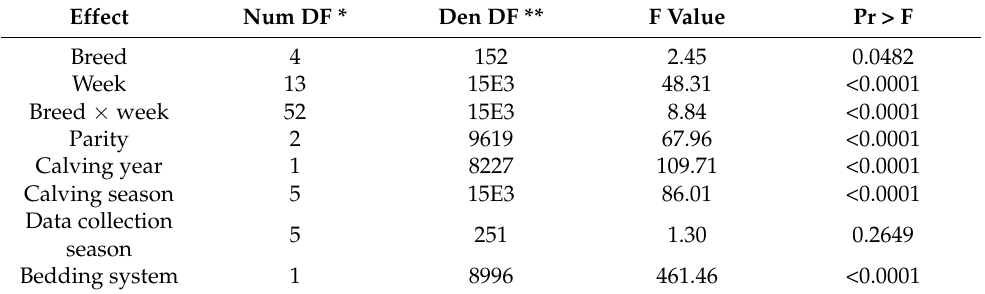
Table A6. Variance analysis results for the variable body weight.